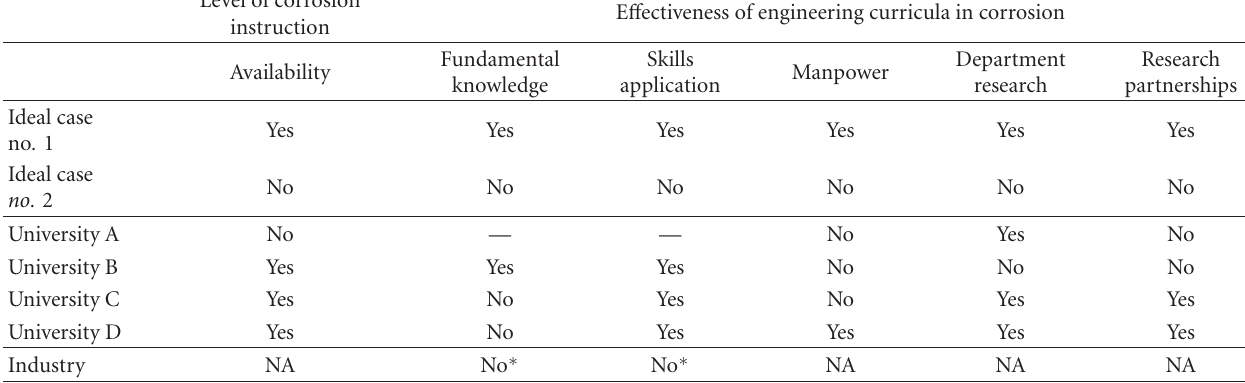
Table 9: Overview of